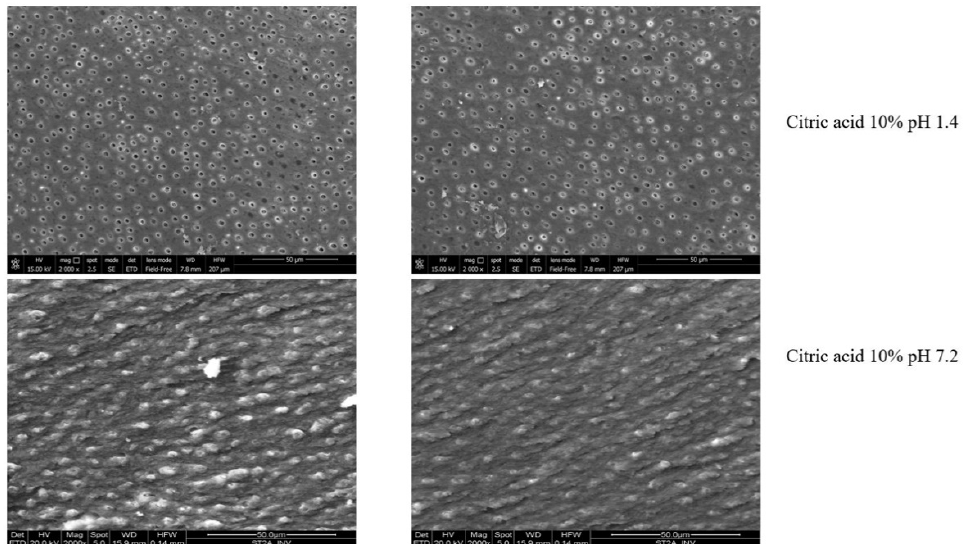
Figure 4. Representative scanning electron microscopy images of root canal walls after final rinse with 10% citric acid at acidic and neutral pH for two minutes. Top: smear layer is removed with dentinal tubules visible using the acidic solution. Bottom: a uniform coating of smear layer covering dentinal tubules was observed on the sample’s surface treated with the solution at neutral pH. Original magnification, 2000 ×